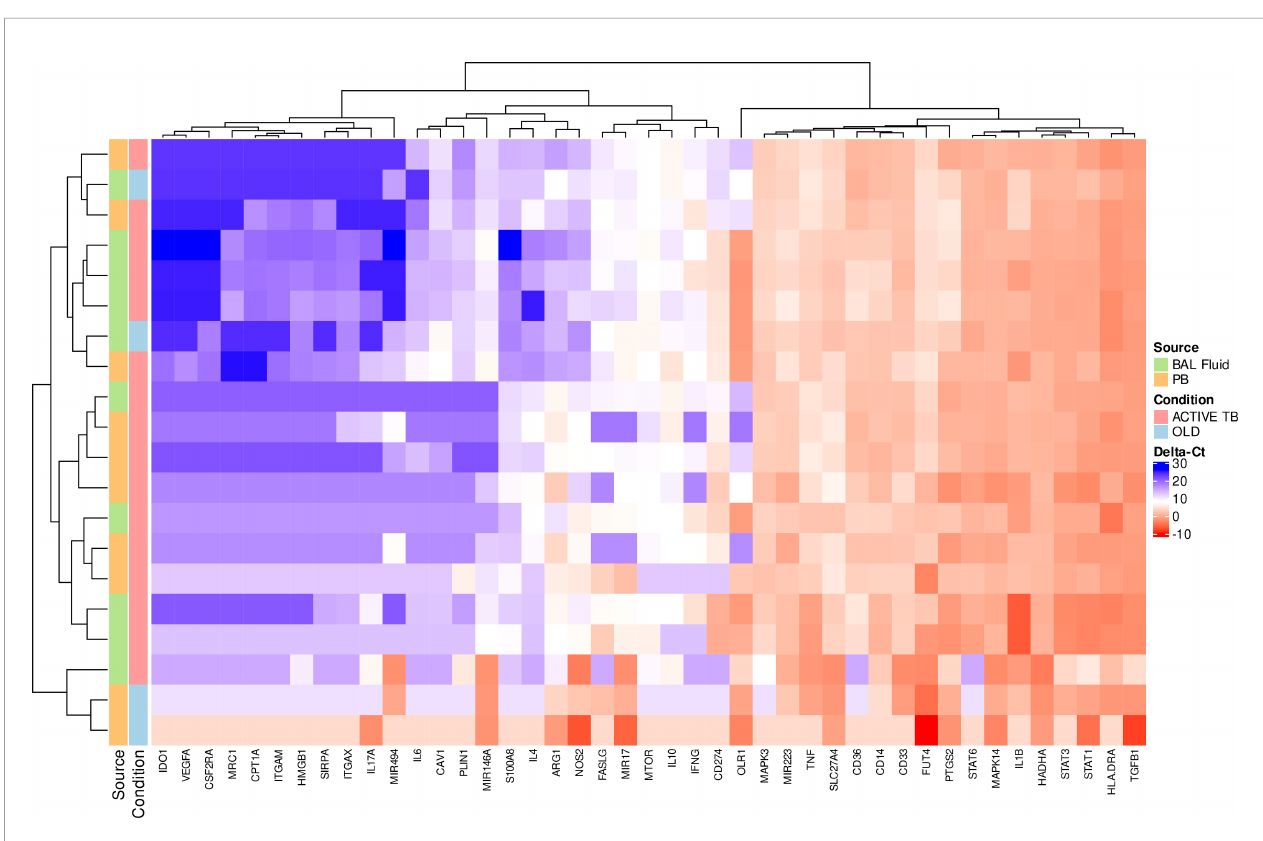
FIGURE 3 | Scaled gene expression patterns of MDSC in BALF and PB (16x pre-ampli fi cation). Lower expression (higher D Ct-values) is indicated by blue. Hierarchical clustering of similar expression patterns across subject and genes is indicated by the dendrograms.